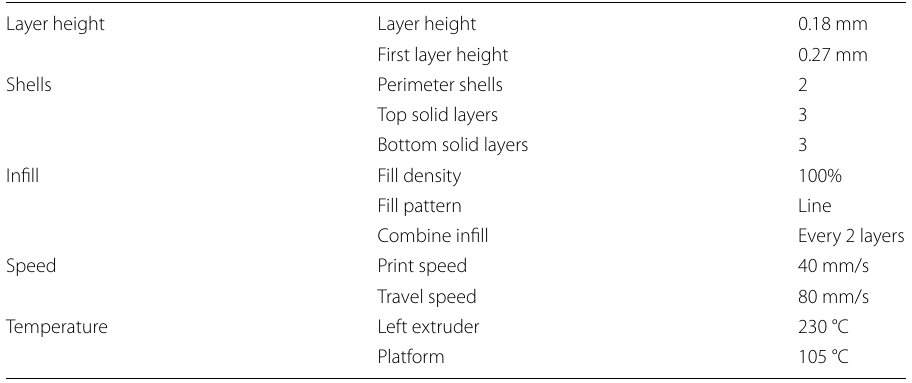
Table 2 Parameters of 3D printer Layer